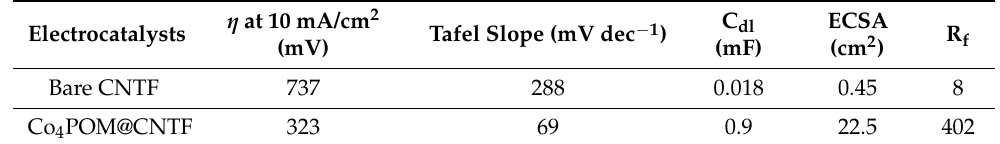
Comparison of electrochemical parameters calculated for the bare CNTF and